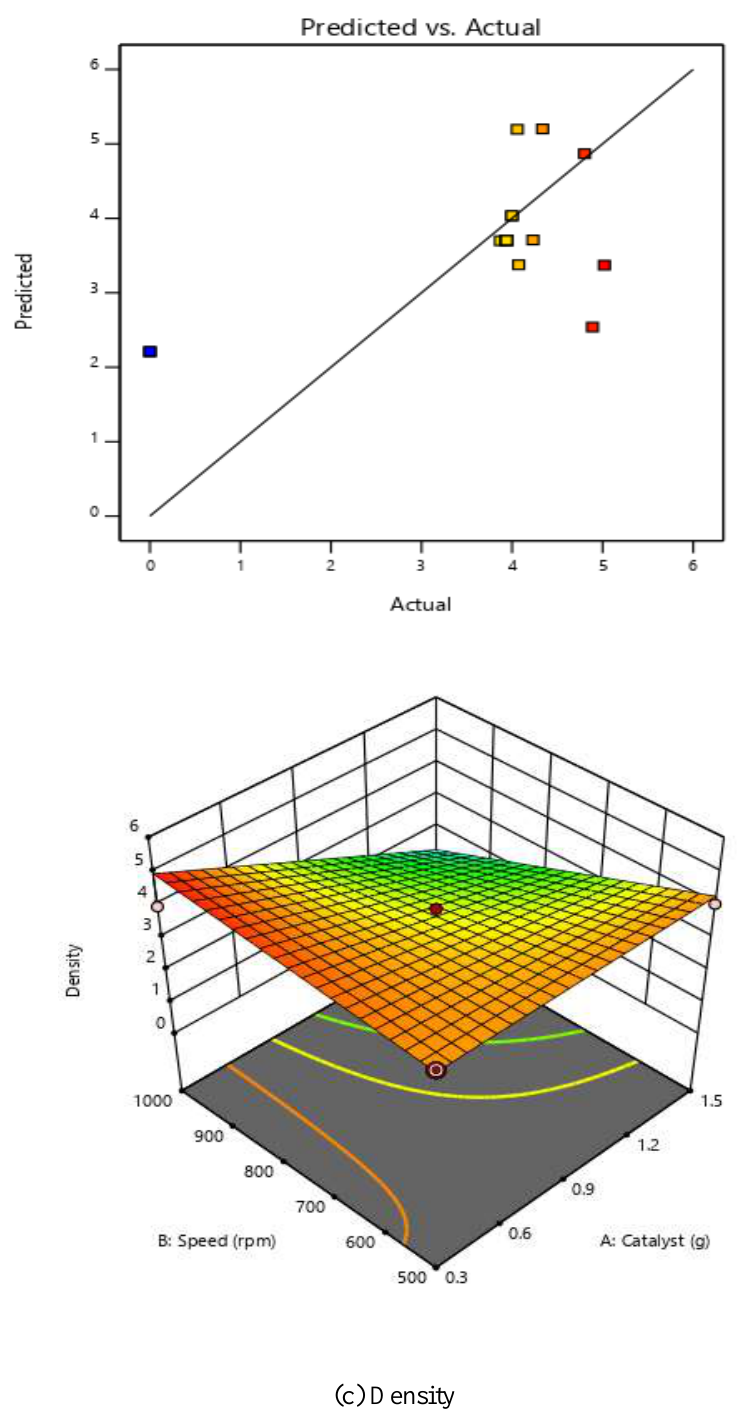
Figure 2: Scatter diagram: (a) yield; (b) specific gravity; (c) density with the corresponding 3D